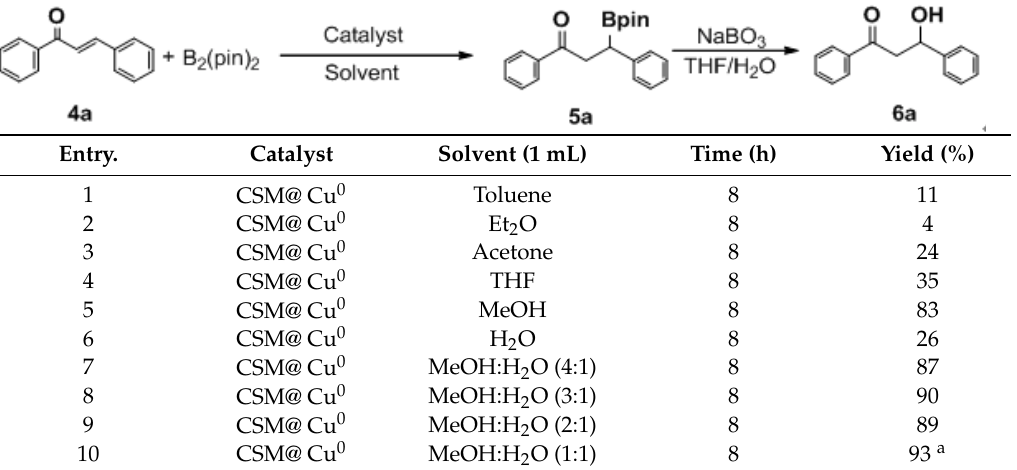
Table 2. Optimization of the Reaction Conditions.